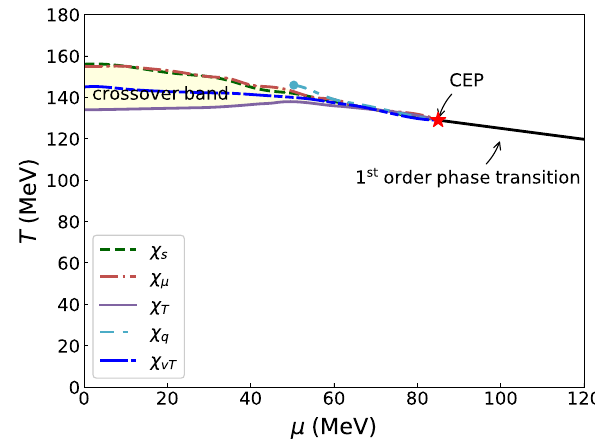
Fig. 5 The critical band of the QCD phase